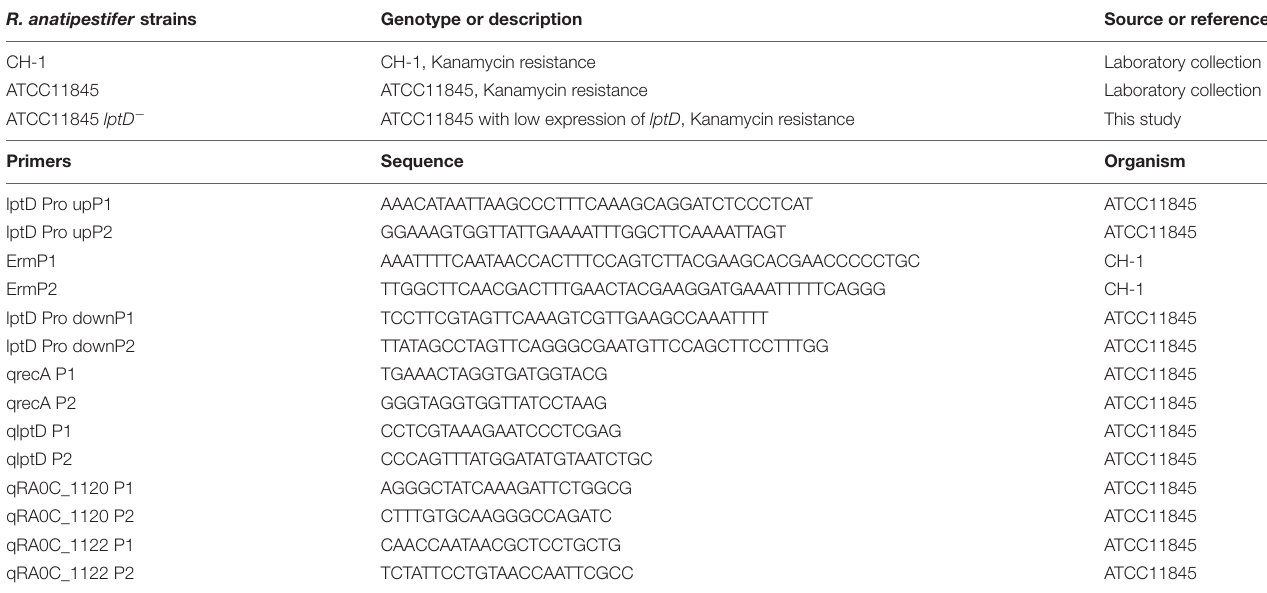
TABLE 1 | Strains and primers used in this